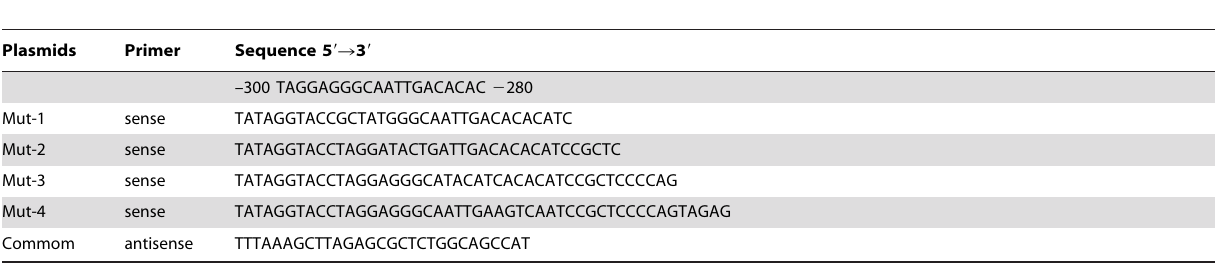
Table 2. Primers used for mutagenesis at the hTFF3